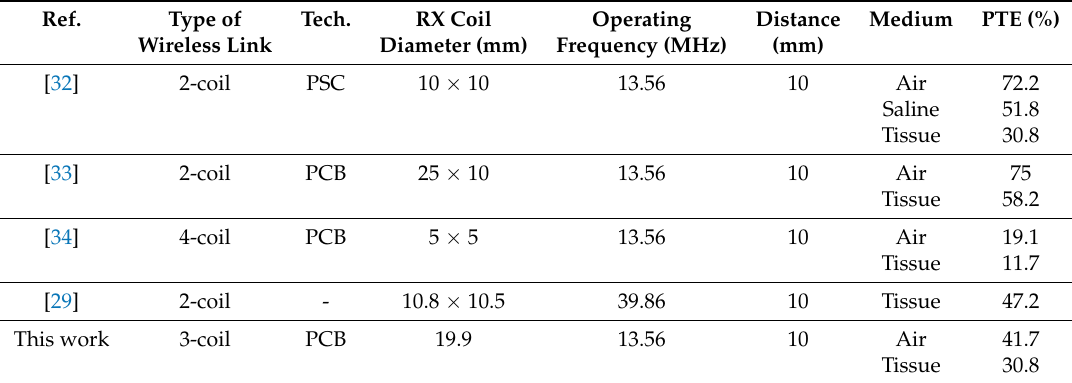
Table 4. Comparison with the Conventional